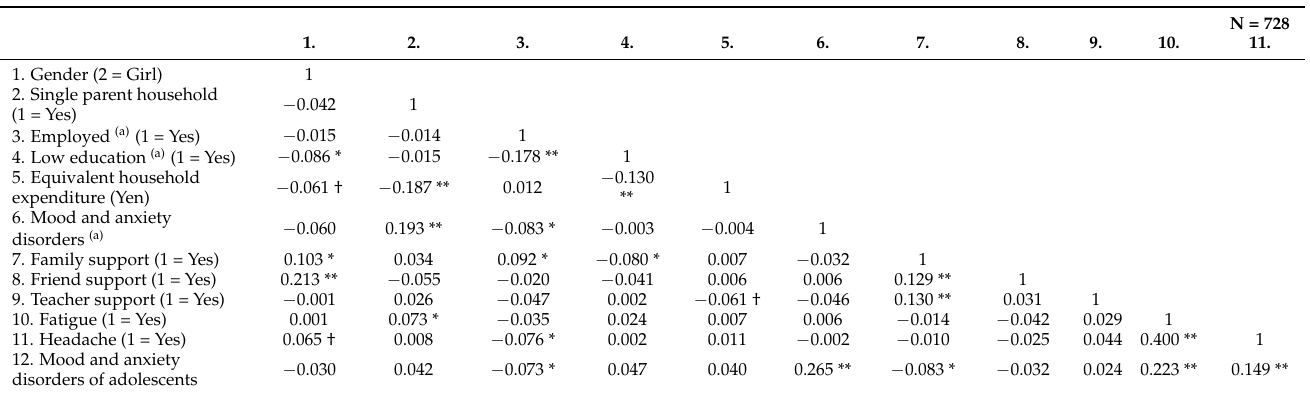
Table 3. Correlation coefficients of the study